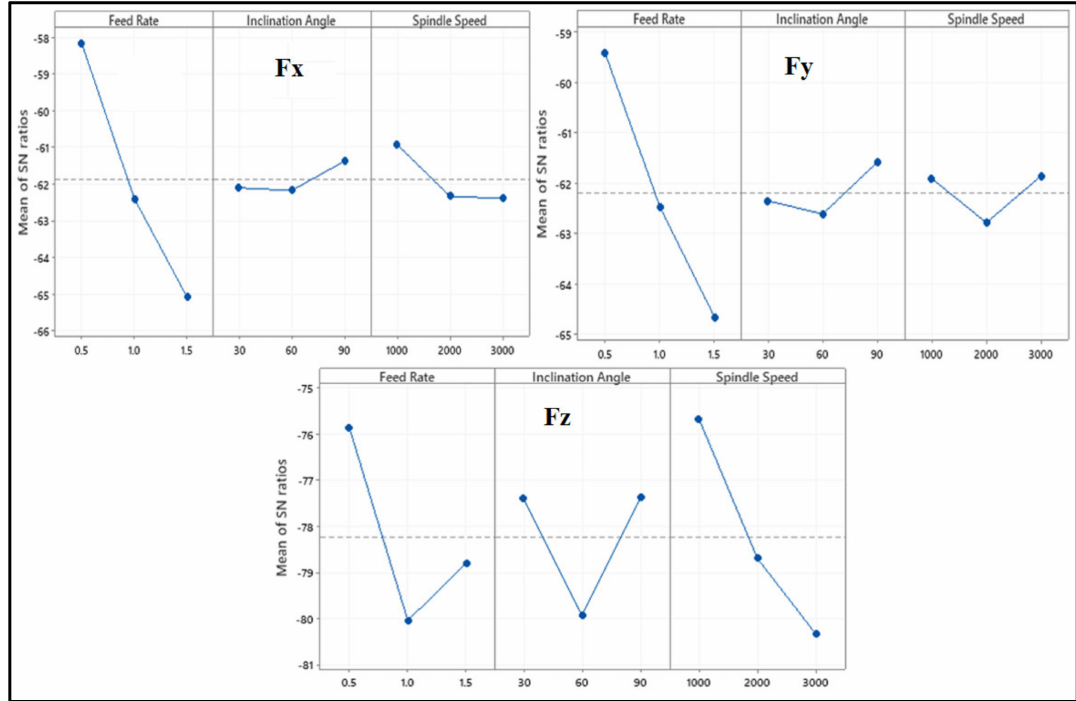
Figure 6. Main E ff ects Plot of S / N ratios for Fx, Fy and